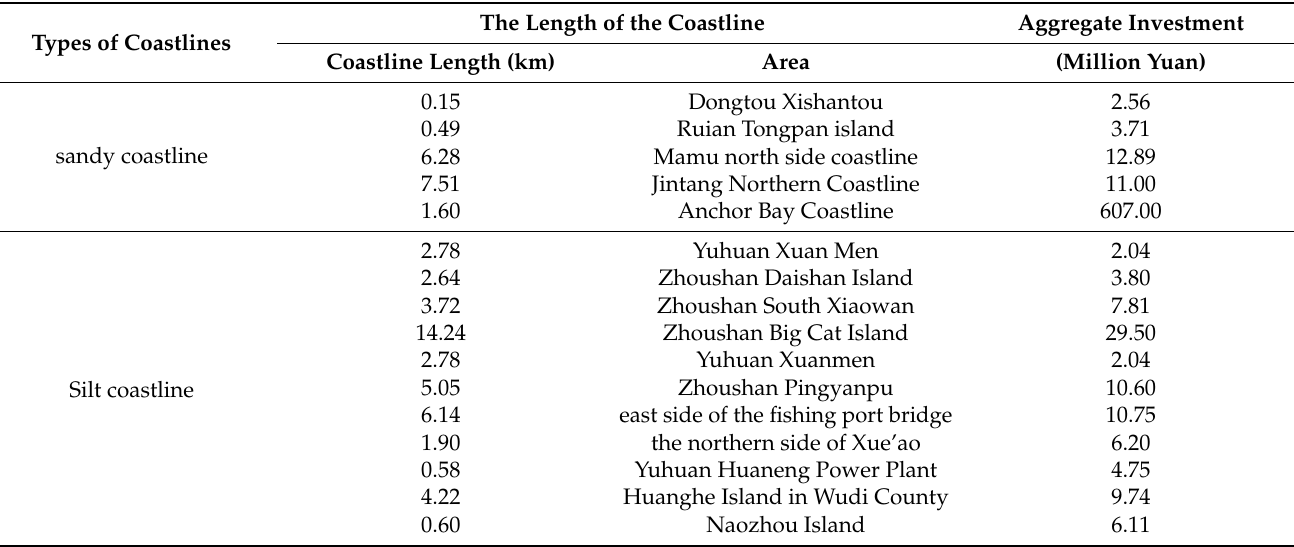
Table A1. The data used to calculate the direct cost, including types of the coastline, length of the coastline, area and aggregate investment.